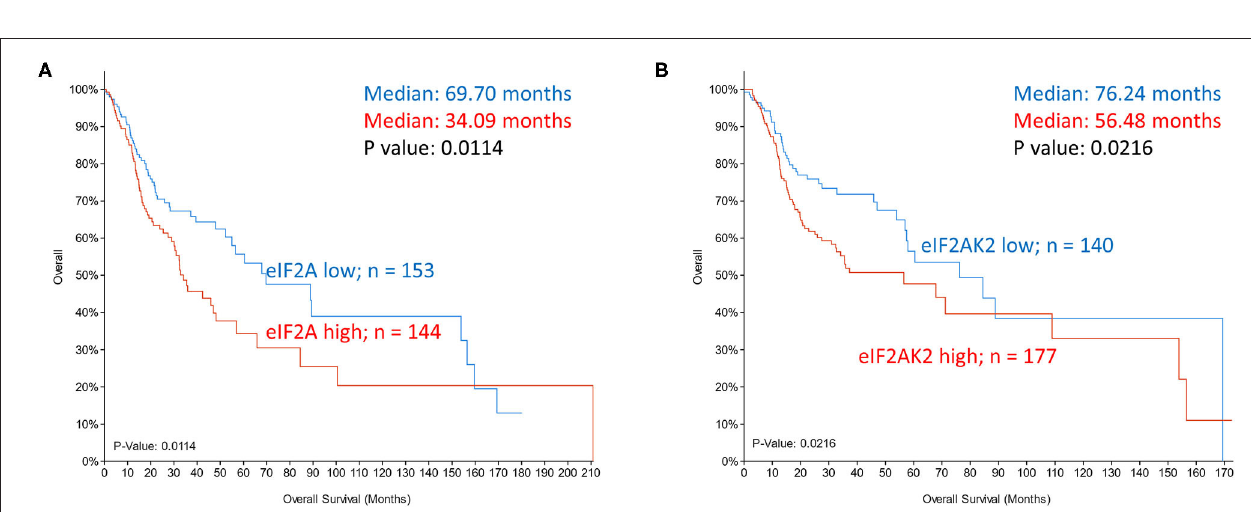
FIGURE 4 | Kaplan-Meier overall survival analysis in TCGA dataset of head and neck cancer patients grouped based on mRNA expression z scores relative to all samples (log RNA Seq V2 RSEM). (A) eIF2A expression in top tercile (144 samples; red ) and bottom tercile (153 samples; blue ). (B) eIF2AK2 (PKR) expression in top tercile (177 samples; red) and bottom tercile (140 samples; blue). P -values are